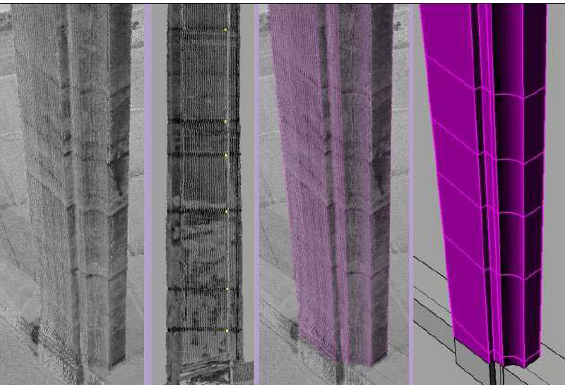
Figure 8: Above: a visual comparison between point cloud and the photogrammetrically extracted primitive. You can see how the column base is not modelled at this point because too rich in details, difficult to extract and model in photogrammetric software. Below: image showing a quantitative check. In green the line in tolerance (< 15 mm) in yellow the acceptable feature (circa 15 mm), in red the out of tolerance feature. As appropriate, the model is corrected and refined later in the real modeling phases or corrected in the photogrammetric software